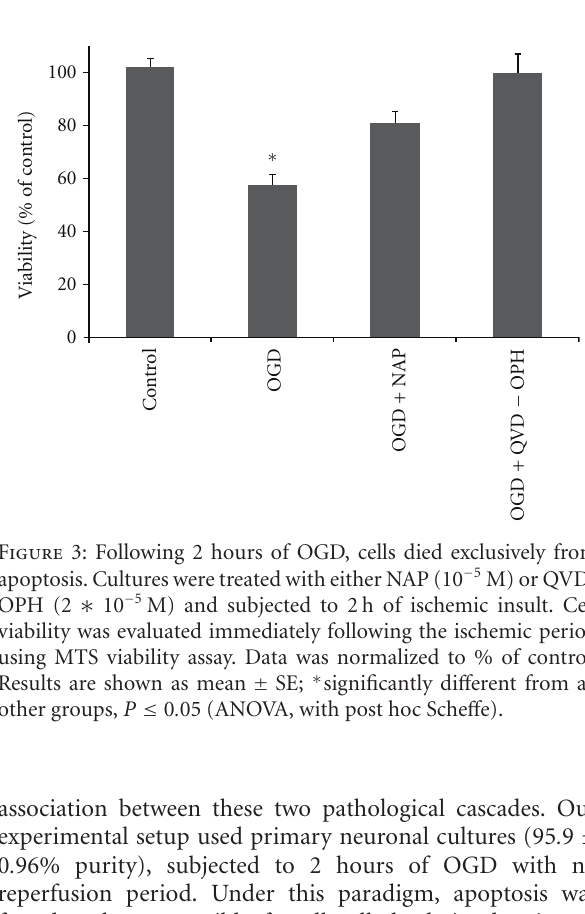
Figure 2: NAP protects from cell death in a dose dependent manner following 2 hours of OGD insult, but not after additional 24 hours reperfusion. Primary neuronal cultures (5-6DIV) were subjected to 2 h of ischemic insult. Cell viability was evaluated using MTS viability assay. Data was normalized to % of control. Results are shown as mean ± SE. ∗ Significantly di ff erent from OGD with no NAP, OGD + NAP10 − 15 M, OGD + NAP10 − 13 M, OGD+NAP10 − 11 M (3 independent experiments are summarized, ANOVA, with post hoc Sche ff e, significant di ff erence considered to be P ≤ 0 . 05). Using LSD post hoc, NAP 10 − 5 M (+), 10 − 7 M are significantly di ff erent from the OGD group ( P < 0 . 05).